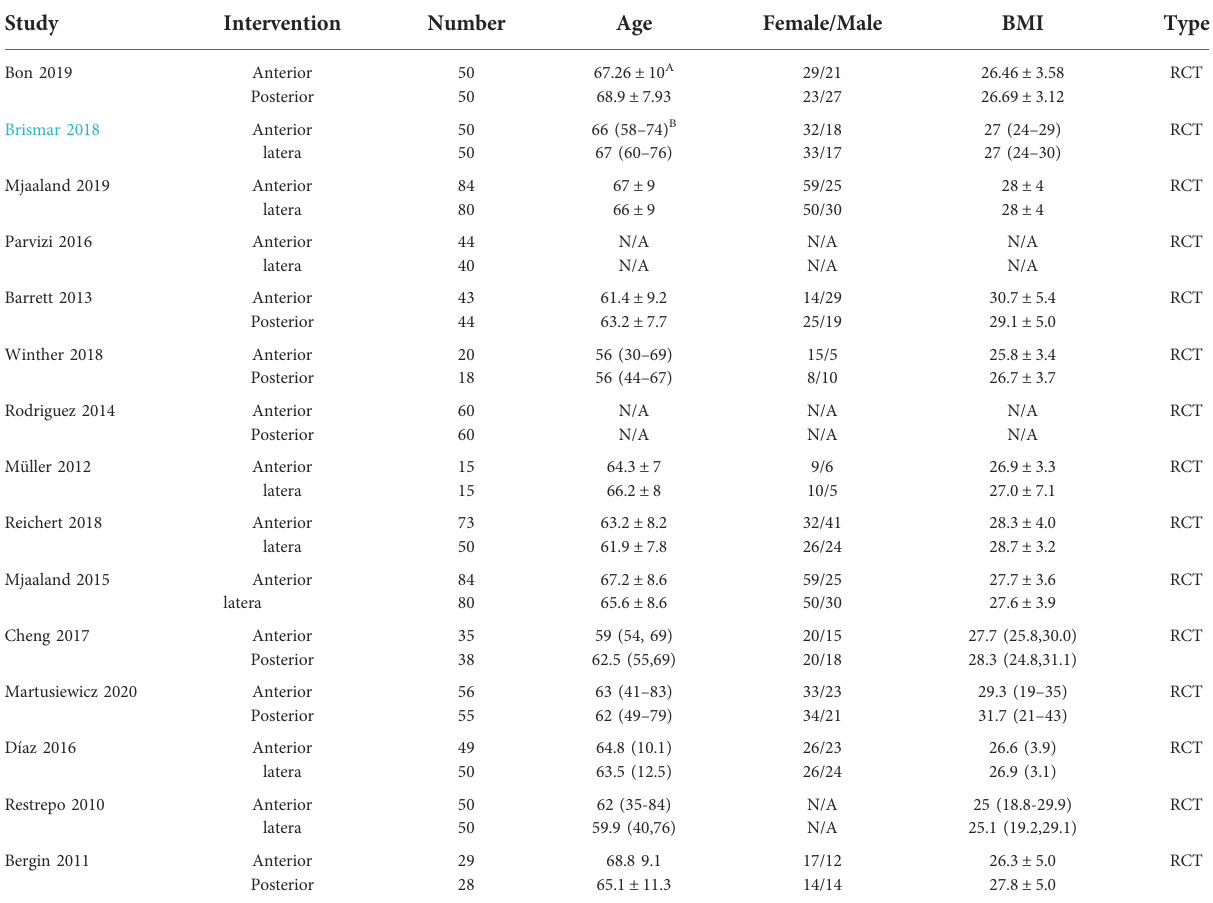
TABLE 1 Characteristics of the selected